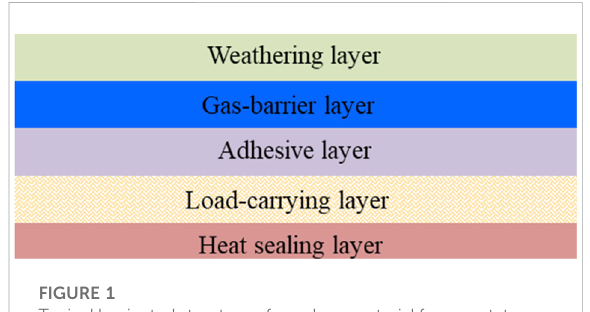
FIGURE 1 Typical laminated structure of envelope material for aerostat.